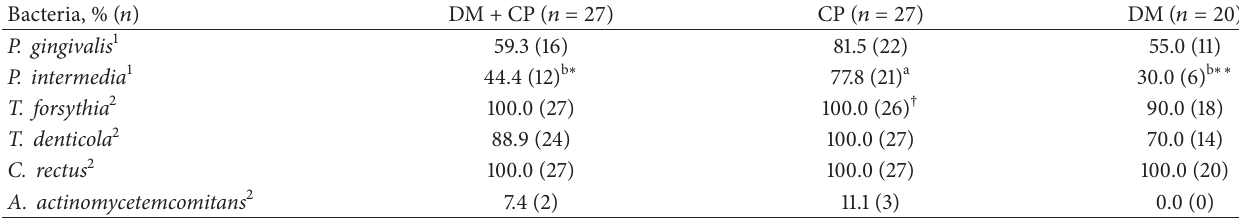
Table 2: Prevalence of periodontal pathogens detected by PCR ( 𝑛 = 74 ).